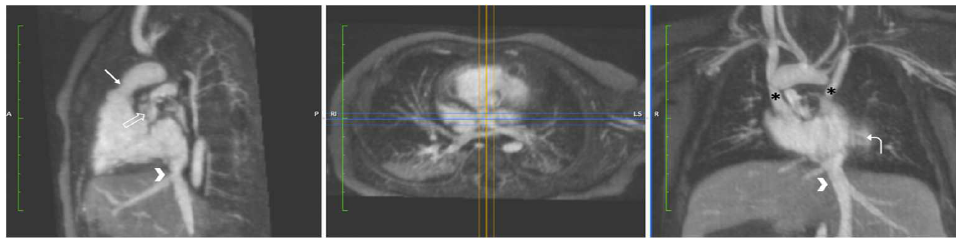
Figure 8. Double Outlet Right Ventricle with Pulmonary Stenosis (DORV/PS) in Heterotaxy Syn- drome. Reformatted multiplanar maximum intensity projections from a 4D FE-MRA (MUSIC) study in an infant with DORV/PS. The aorta (solid arrow) arises from the right ventricle and is positioned anterior and rightward of the pulmonary artery (open arrow). The heart is positioned in the midline (mesocardia) with a leftward pointing apex (curved arrow). There are bilateral SVCs without a bridging vein (asterisks) and the IVC is left-sided, connecting to the leftward half of a common atrium (arrowheads). The liver is transverse.